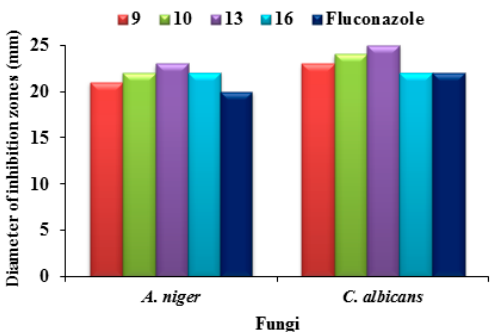
Figure 4. Antifungal activity of the most potent compounds against different fungal strains.